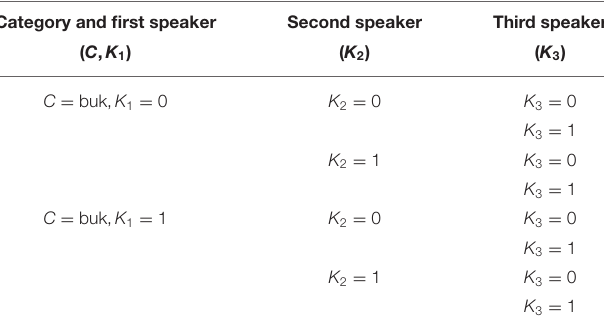
TABLE 2 | Hypothesis space given a scenario where the object label ( C ) is known, but the knowledgeability of three informants ( K 1 , K 2 , K 3 ) is unknown.